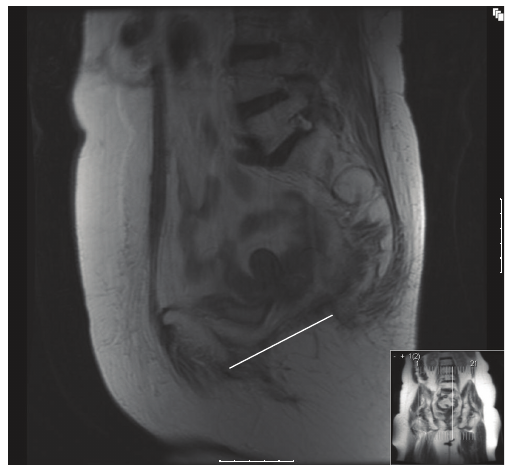
Figure 1: T 2 -weighted saggital view. Patient lying supine with breath held. White line represents “modified pubococcygeal”